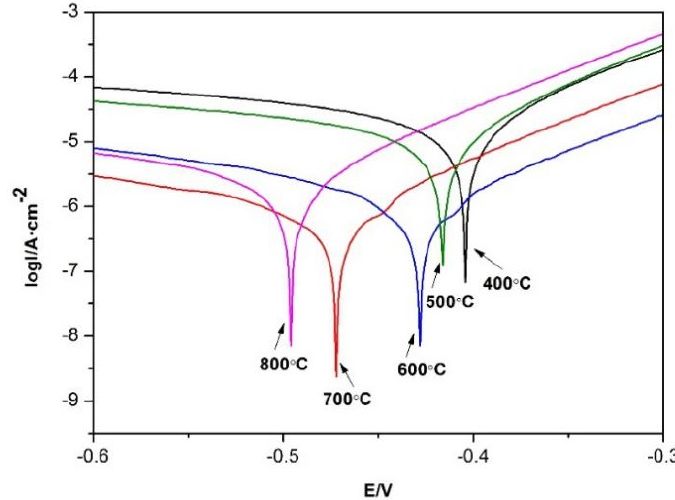
Figure 10. Tafel polarization curves of Ni coatings after treatments at high temperatures. Table 4. E corr , I corr and R p values of Ni / ZrO 2 gradient coatings after treatments at high temperatures. Temperature / ◦ C E corr / V I corr / A · cm − 2